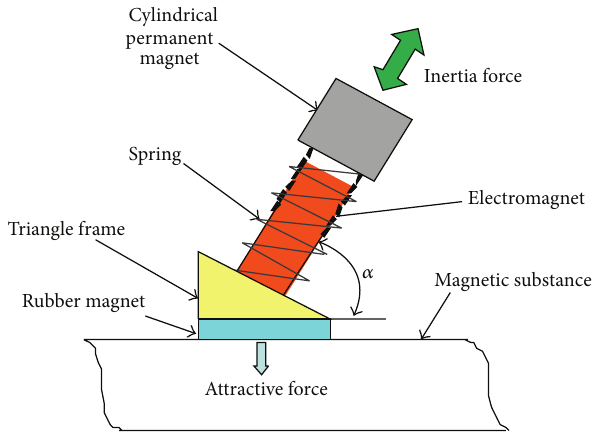
Figure 1: Structure of the magnetic